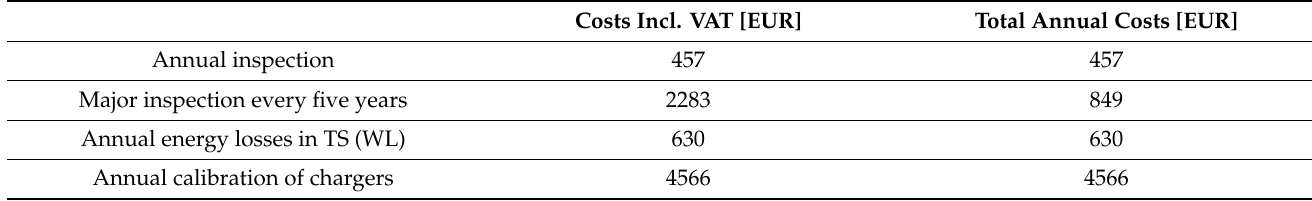
Table 3. Fixed operating